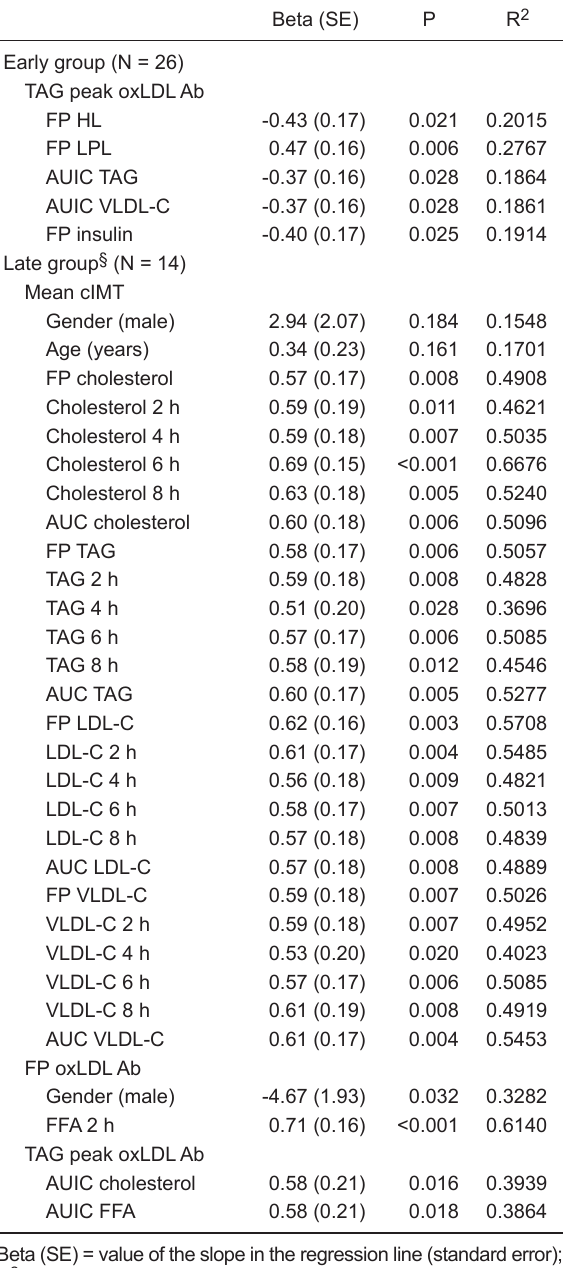
Table 2. Univariate linear regression analysis for subclinical ca- rotid atherosclerosis and antibodies against oxidized LDL in early and late